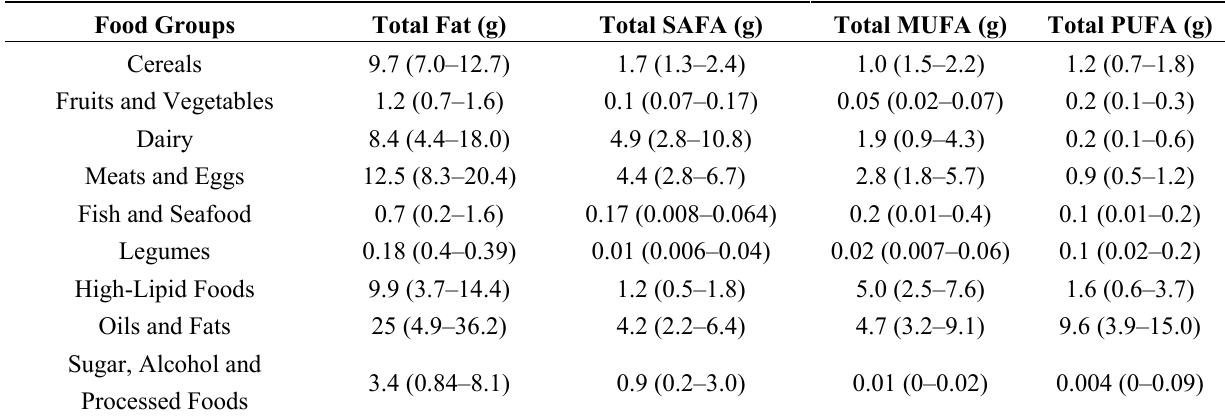
Table 4. Fatty acid intake according to food